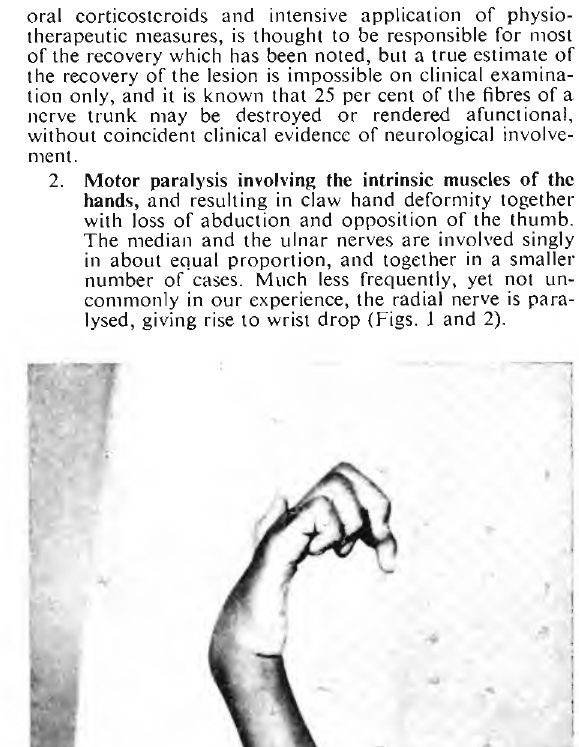
Fig. I — Combined ulnar and median nerve paralysis , showing the typical " Simian hand" but without hyperextension at the metacarpo-phalangeal joints.